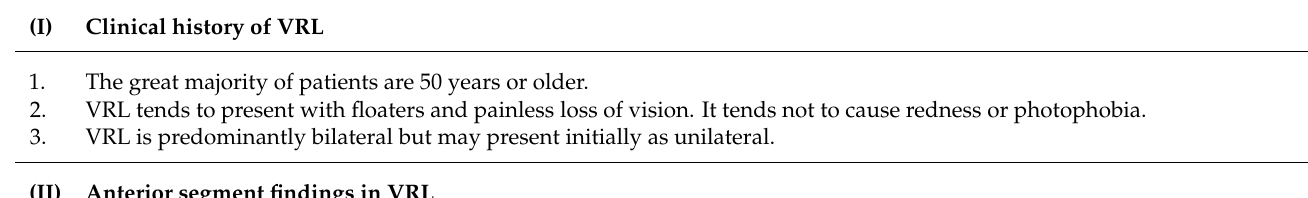
Table 1. Guideline: consensus recommendations for the diagnosis of vitreoretinal lymphoma [55] (with copyright permission from the